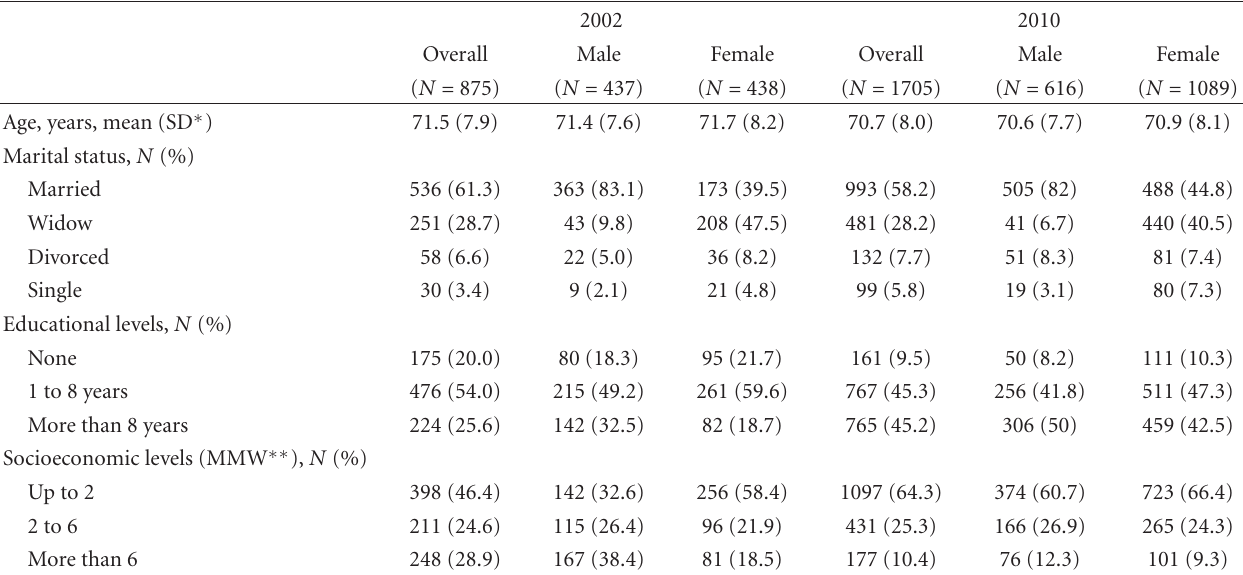
Table 1: Characteristics of the older adults living in Florian´opolis, Brazil, in years 2002 and 2010.